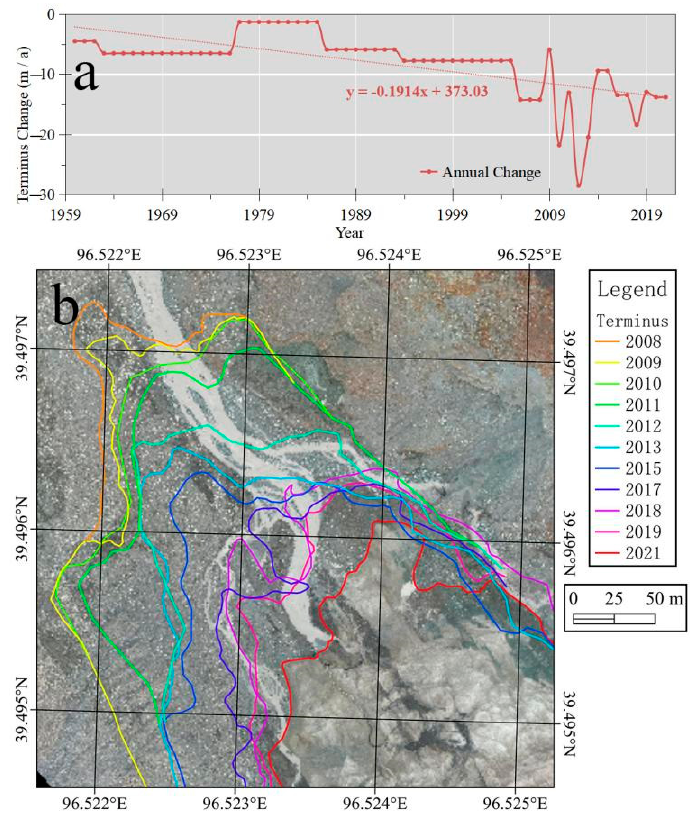
Figure 3. Terminus changes of LHG12. ( a ) Terminus changes in 1959–2021. The data source for the